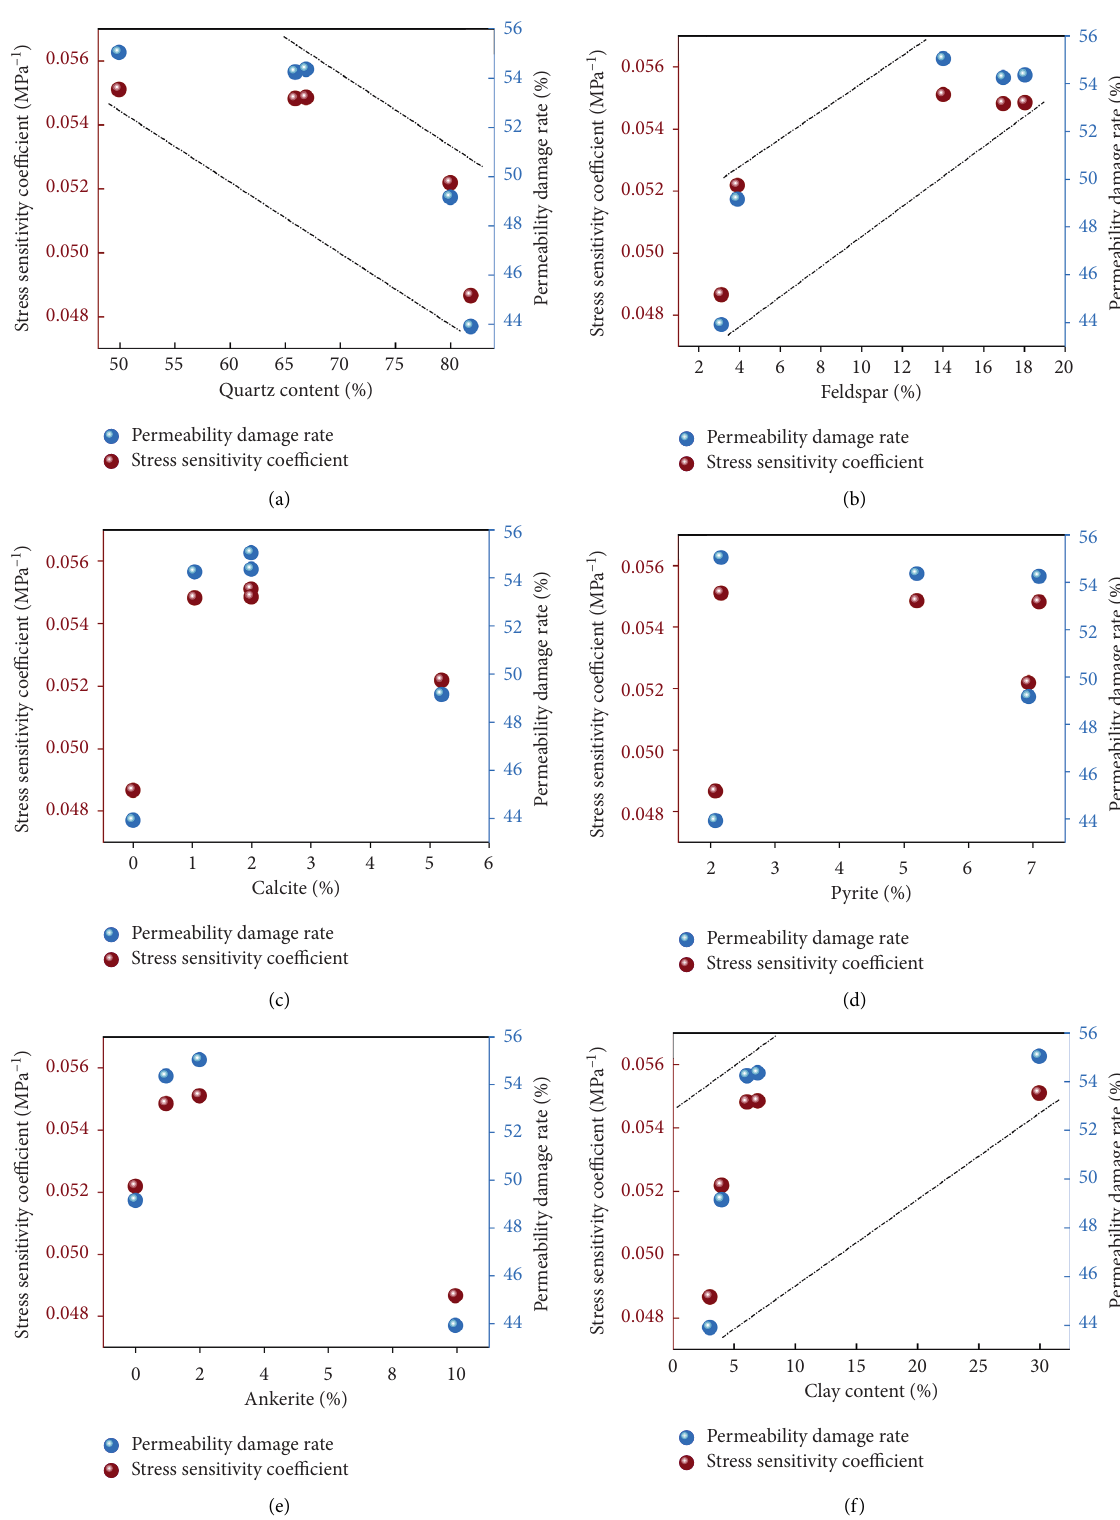
Figure 7: Relationships between mineral components and shale permeability impairment rates and stress sensitivity